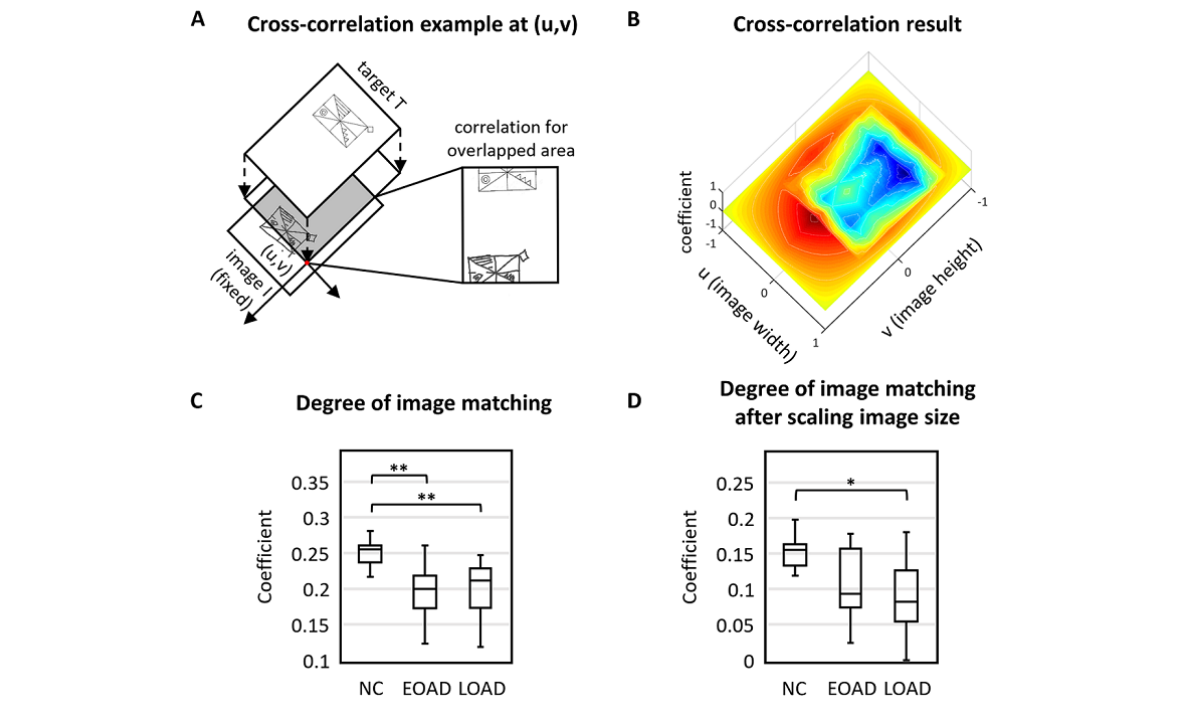
Figure 4. Shape similarity between the target and the pictures drawn by the participants. (A) The Pearson correlation coefficient was used to assess cross-correlation for all possible overlap. (B). We applied 2D cross-correlation analysis and calculated its coefficient and shift in space. (C) For both AD groups, pattern matching was significantly poorer than that of the normal control (NC) group (pairwise Mann-Whitney U test: P =.004 for early-onset Alzheimer disease [EOAD] vs NCs and P =.002 for late-onset Alzheimer disease [LOAD] vs NCs). There was no statistical significance between the EOAD and LOAD groups ( P =.86). (D) Although the amount of difference was reduced, the similarity was significantly lower for the LOAD group even after rescaling the image size ( P =.04). There was no statistical significance for the EOAD group even after adjusting for image size. One and two asterisks show significant differences at P <.05 and P <.01 levels, respectively. RCFT: Rey-Osterrieth Complex Figure